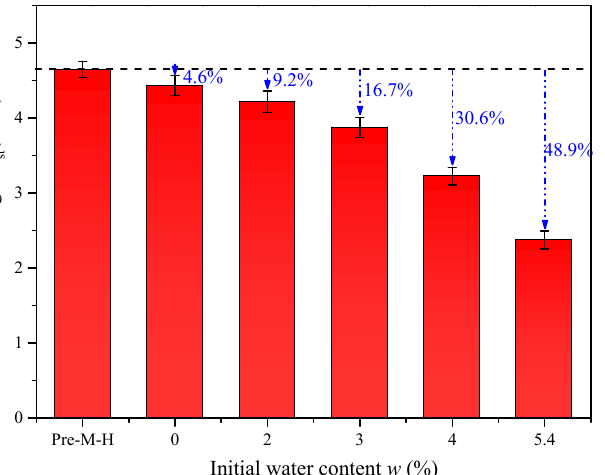
Figure 18. Static Brazilian tests: tensile strength of sandstone with different initial water content after microwave radiation.